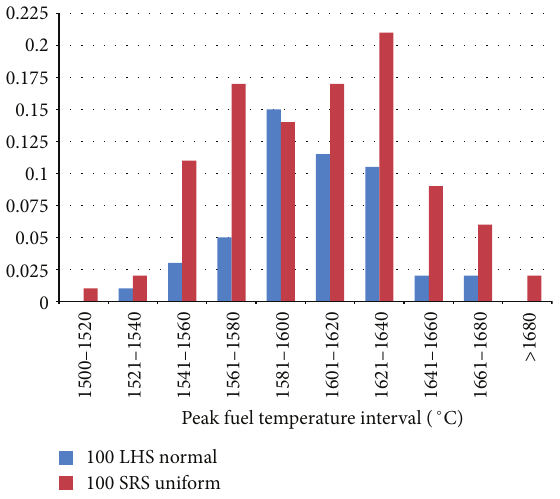
F 10: Normalized peak DLOFC fuel temperature histograms for the 100 LHS Normal and Uniform sets.